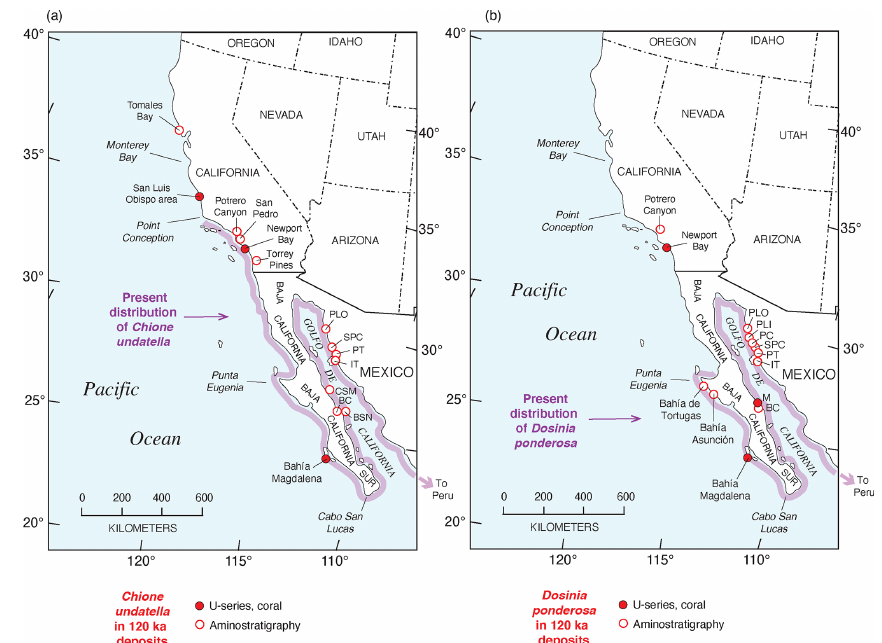
Figure 40. Examples of extralimital southern species of bivalves indicating sea surface temperatures higher than present during MIS 5e (filled and open circles); also shown, in light purple shading, are the modern ranges of these taxa (from Coan and Valentich-Scott, 2012): (a) Chione undatella and (b) Dosinia ponderosa . Age and fossil data compiled from sources as follows: Jordan (1936), Valentine (1956, 1960), Kanakoff and Emerson (1959), Johnson (1962), Omura et al. (1979), Emerson (1980), Emerson et al. (1981), Kennedy et al. (1982), Ashby et al. (1987), Keenan et al. (1987), Ortlieb (1987, 1991), Grove et al. (1995), Grant et al. (1999), Kennedy (2000), and Muhs and Groves